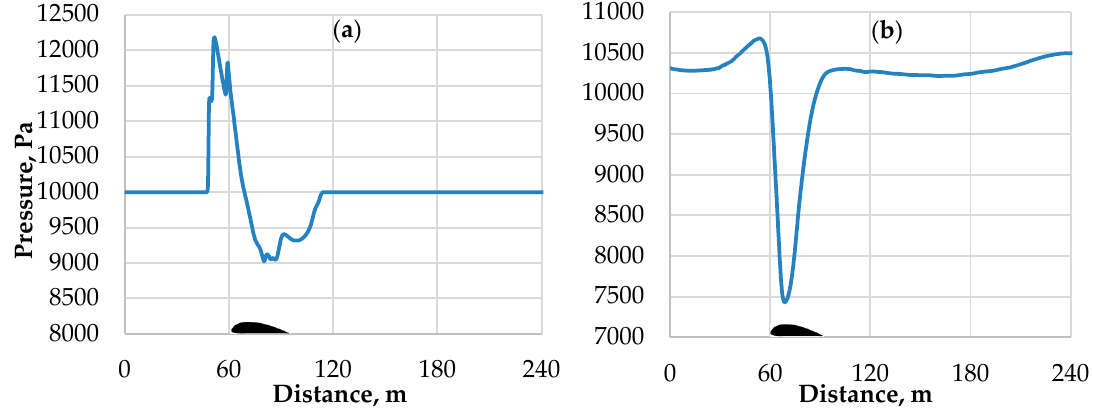
Figure 6. Pressure distribution along the tunnel 4 m above the ground and 0.7 m above the thickest section of the vehicle: ( a ) shows the state after 0.05 s and ( b ) shows the state after 4.65 s.